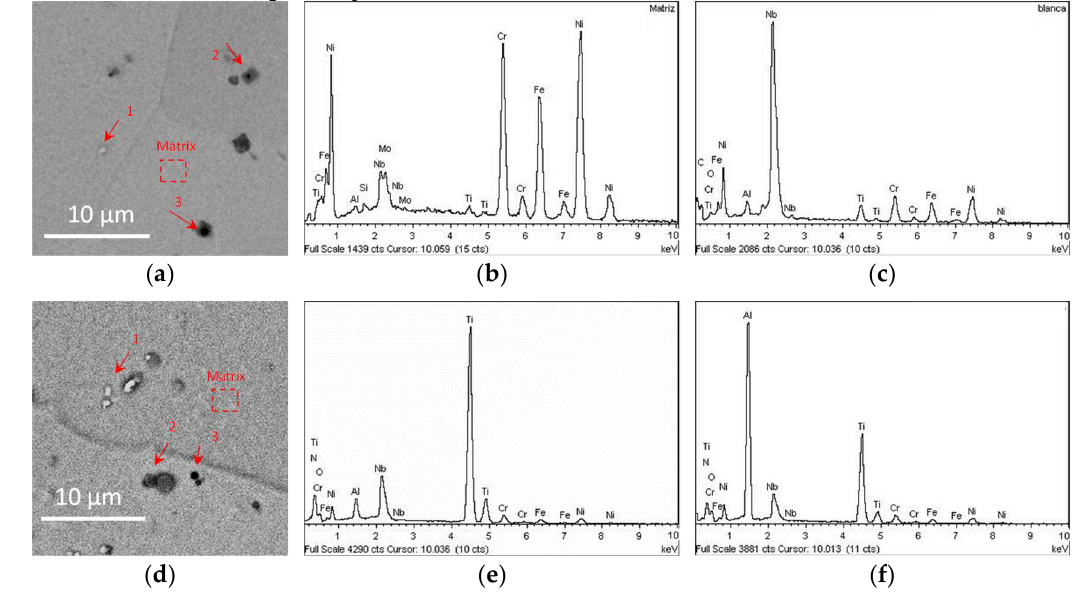
Figure 11. SEM analysis: ( a ) Homogenized sample; ( d ) STA sample; ( b ) matrix EDS; ( c ) 1-white particle EDS; ( e ) 2-Grey particle EDS; ( f ) 3-Black particle EDS.